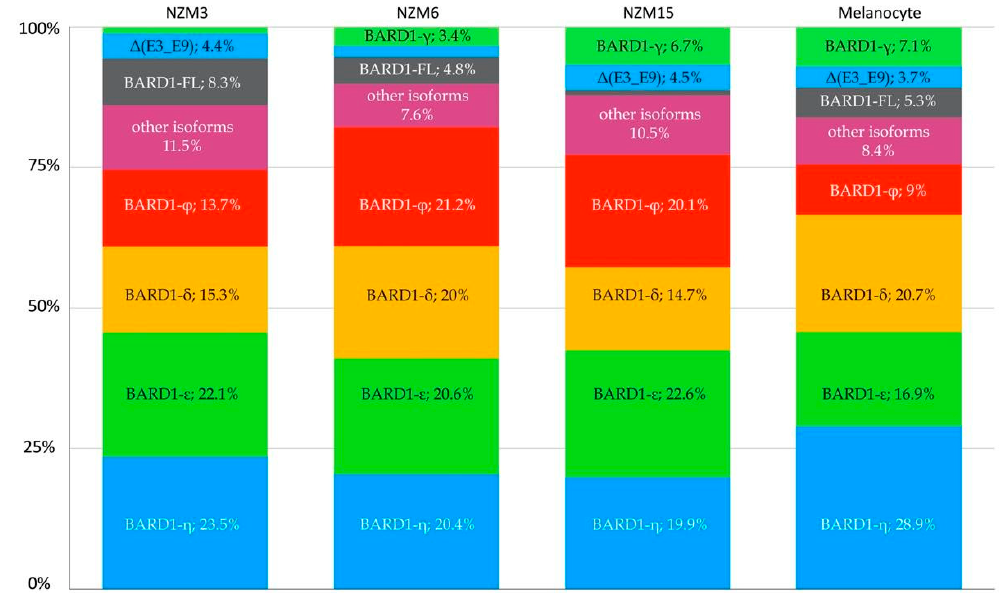
Figure 2. Proportion of BARD1 transcript isoforms quantified using nanopore sequencing. The first three bars correspond to the New Zealand melanoma (NZM) cell lines, and the last bar corresponds to the non-malignant (melanocyte) control.